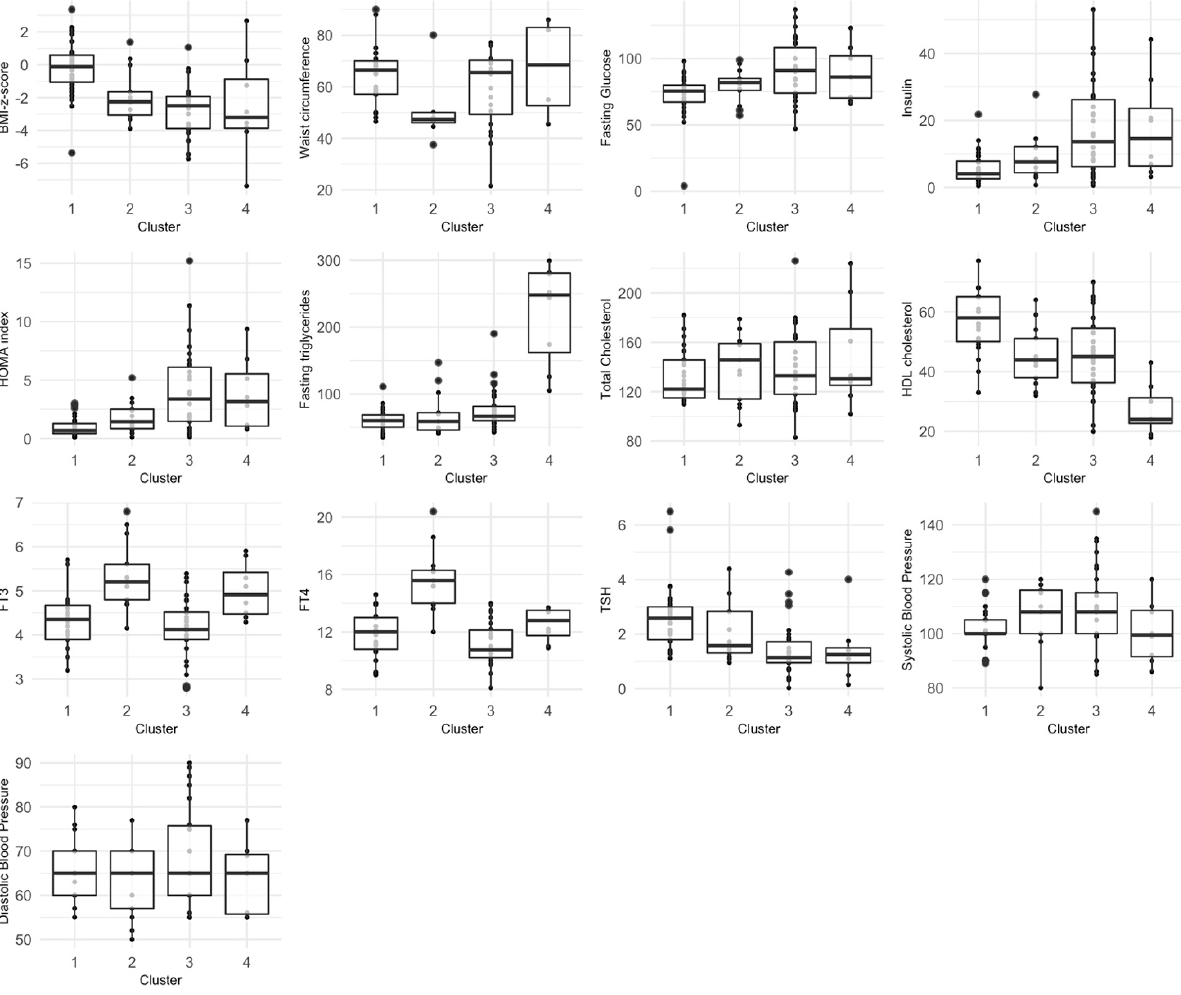
Figure A3. Boxplot showing the distribution of the numeric variables separated by cluster found with hierarchical clustering on principal components.